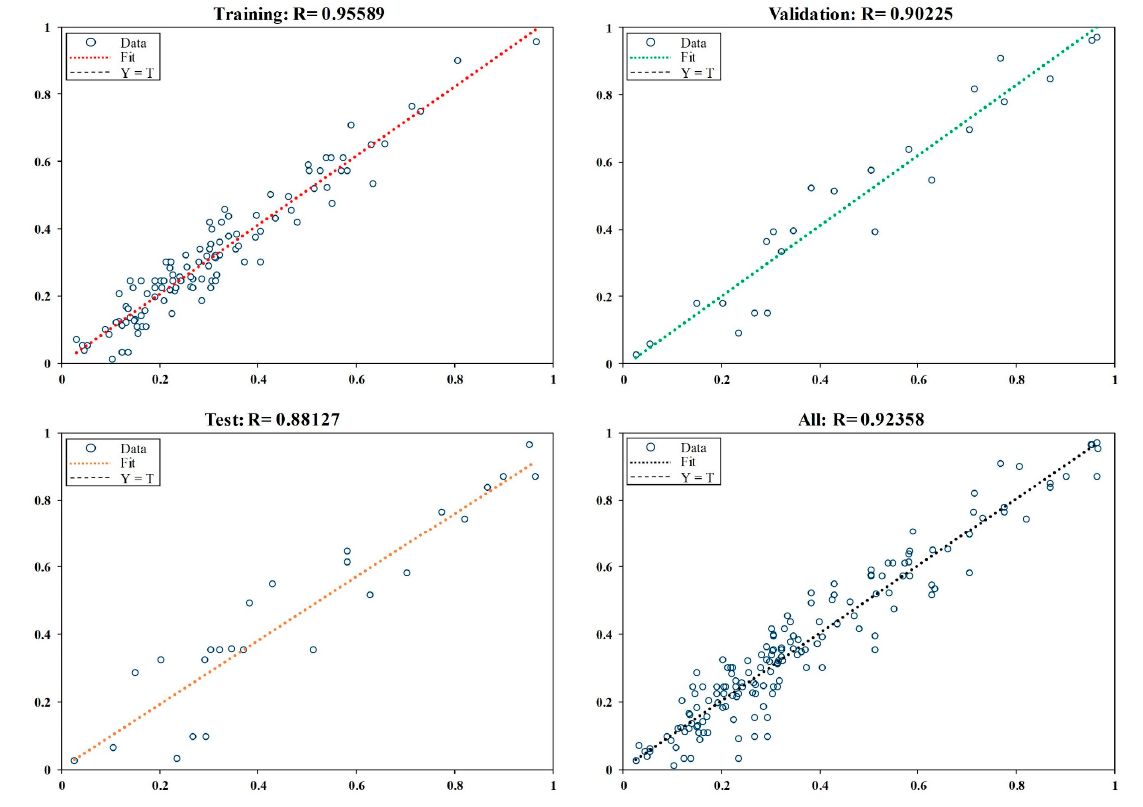
Figure 12. The obtained fitting diagrams and the related correlation coefficients in different stages of the network.